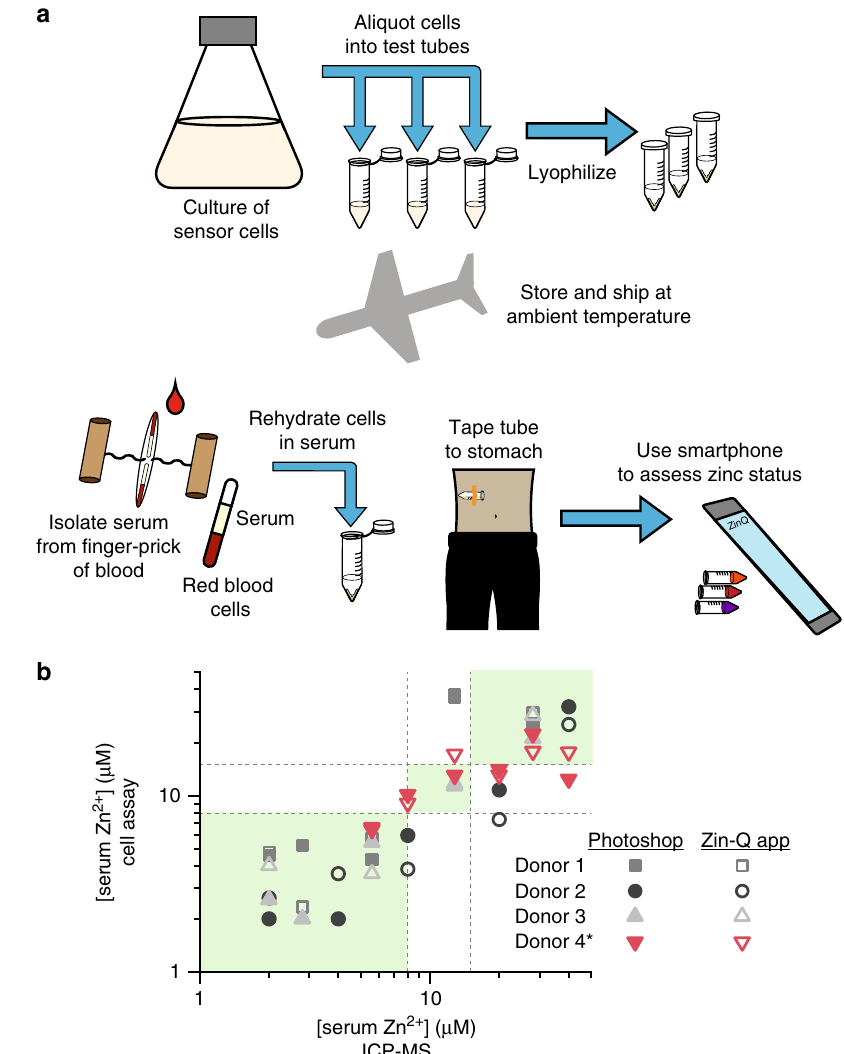
Fig. 6 Accurate zinc assessment in a minimal-equipment setting. a Schematic of proposed work fl ow for in- fi eld zinc assessment with sensor cells. During test manufacture, a large culture of repressed sensor cells is aliquoted into individual test tubes, and cells are lyophilized. Lyophilized tests can be shipped at ambient temperature to the site of testing, where serum will be isolated from a fi nger stick of blood and used to rehydrate the lyophilized sensor cells. Sensor cells can be incubated at ~37 °C by taping tubes to the body. After incubation, the test can be interpreted with an easy-to-use smartphone app. b Assessment of zinc status from color quanti fi cation. Images containing pellets of standards and a test reaction were processed either with Photoshop or with the Zin-Q smartphone app. A calibration curve was calculated from each image, and this was used to assess the concentration of zinc in the test reaction. When results are processed both with Photoshop and with the Zin-Q app, the test accurately classi fi es all serum samples with low zinc levels. Accurate classi fi cation of low, borderline, and high serum zinc is indicated by points in the green area of the plot. The asterisk indicates that serum from Donor 4 was not used in test standards. Source data for b are provided in the Source Data fi